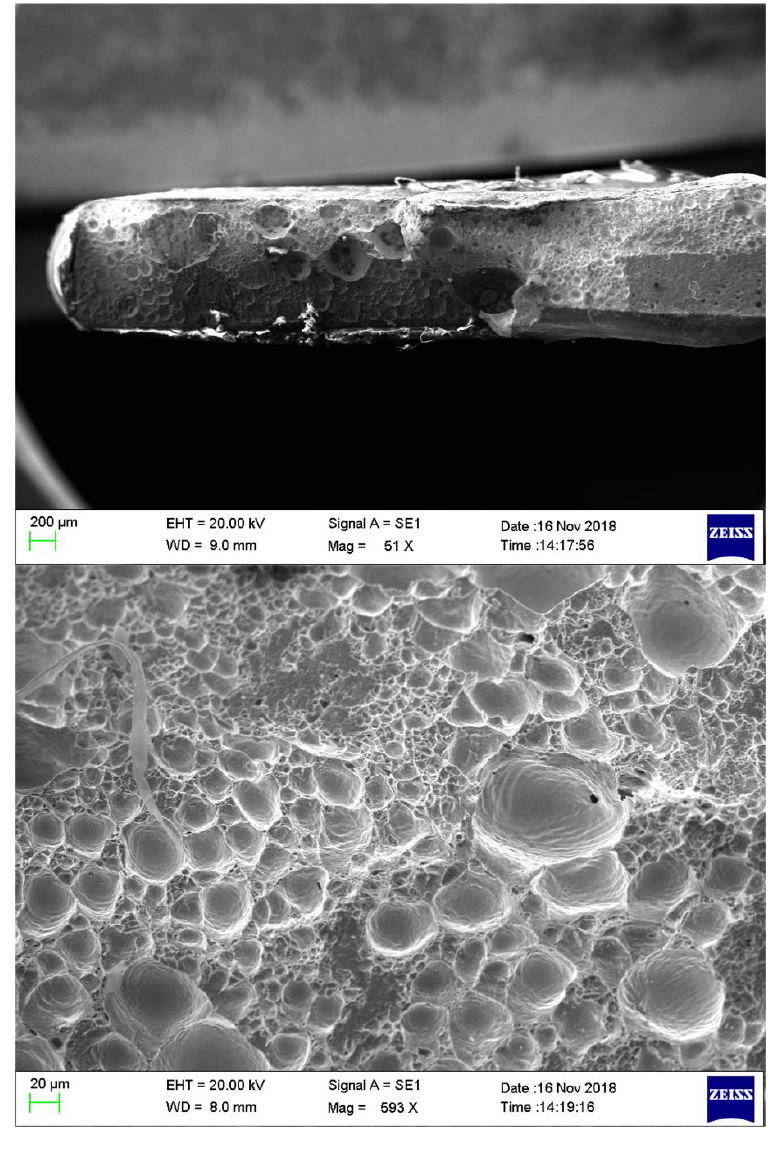
Figure 13. SEM graph of fracture su rface at − 50 °C (ductile).